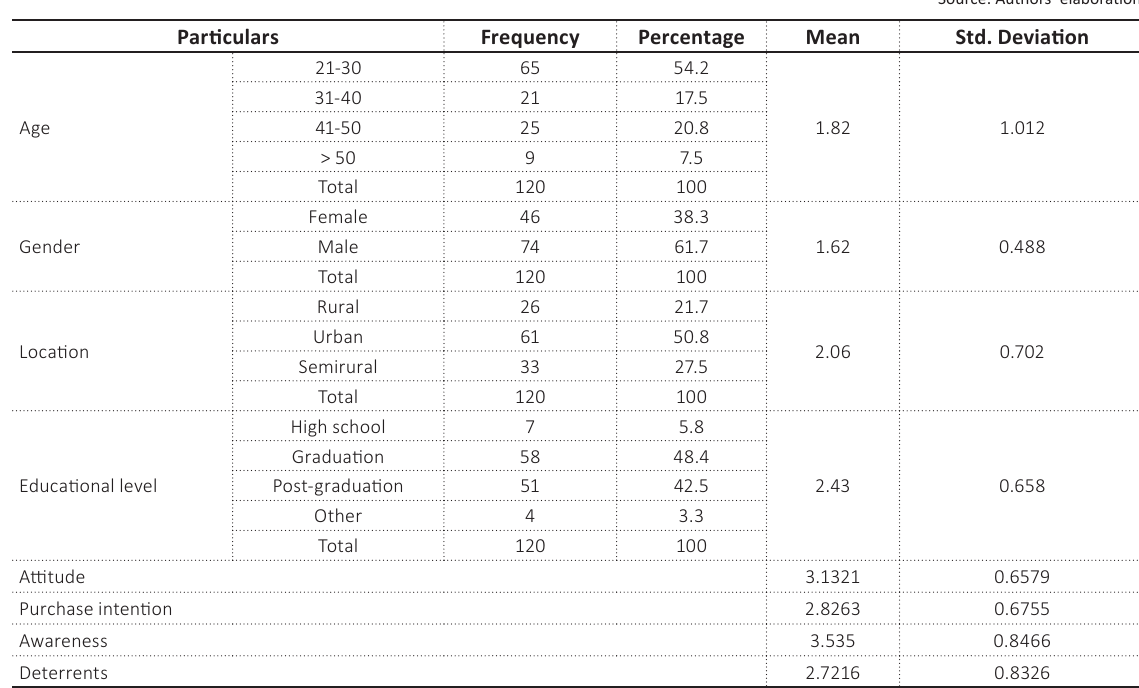
Table 1. Demographic profiling of wine